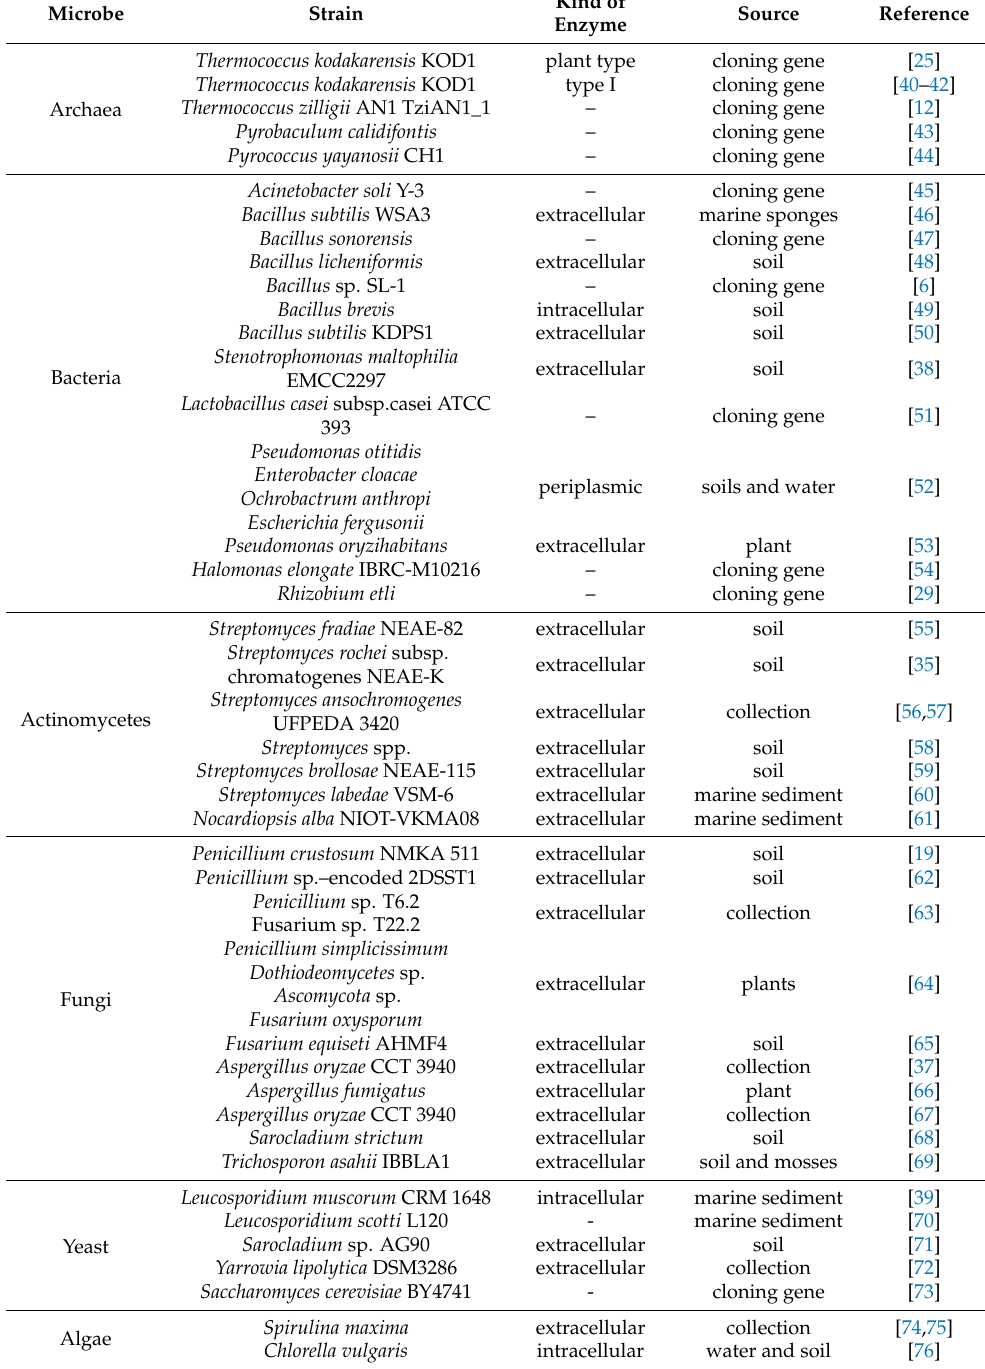
Table 1. L-asparaginase from